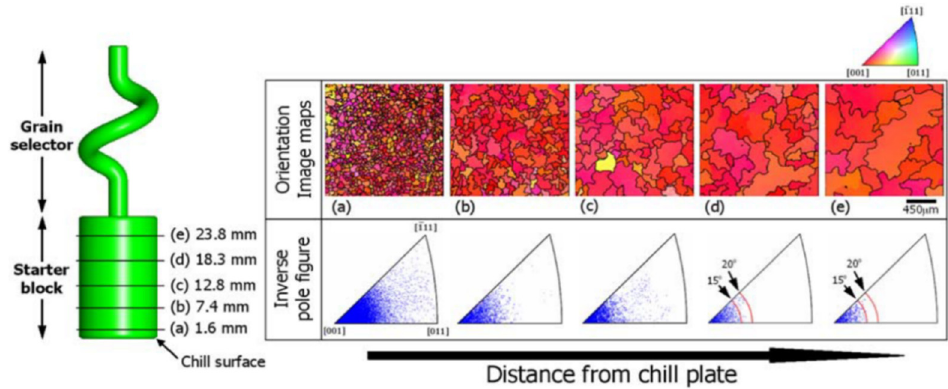
Figure 7. Electron backscatter di ff raction (EBSD) orientation image map and corresponding inverse pole figures at various positions of the starter block (reproduced with permission from [33], Springer Nature,